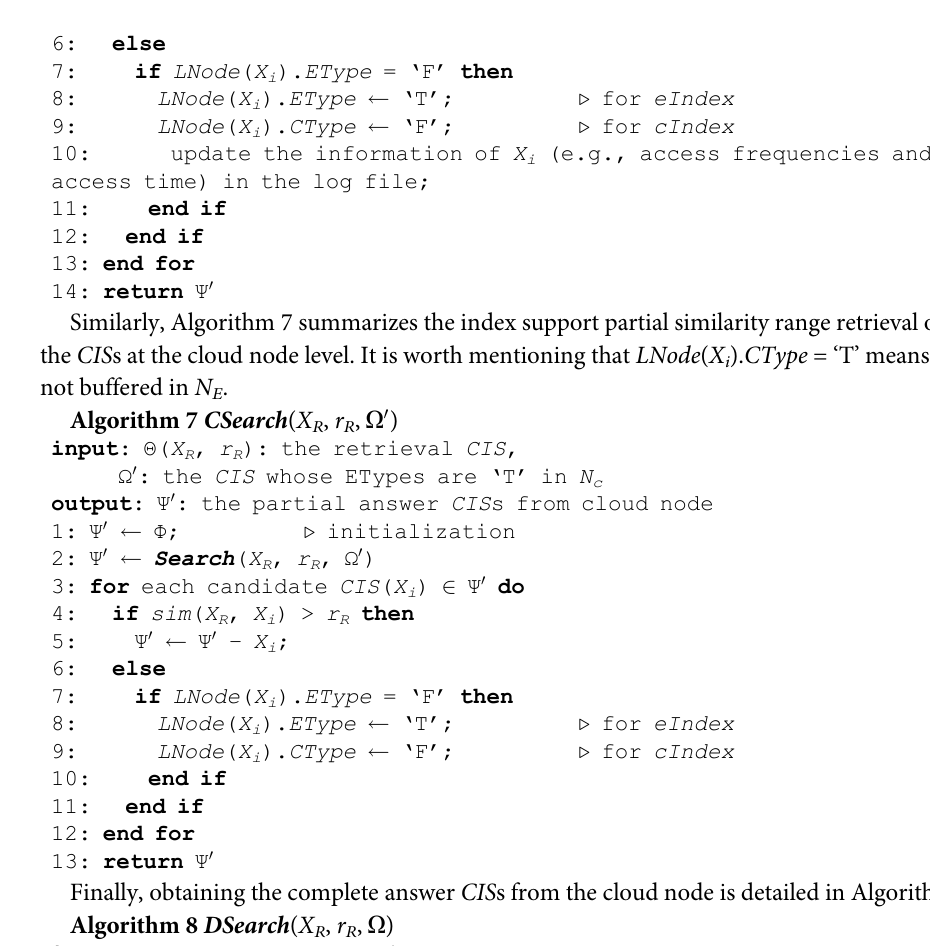
Algorithm 9 Search ( X